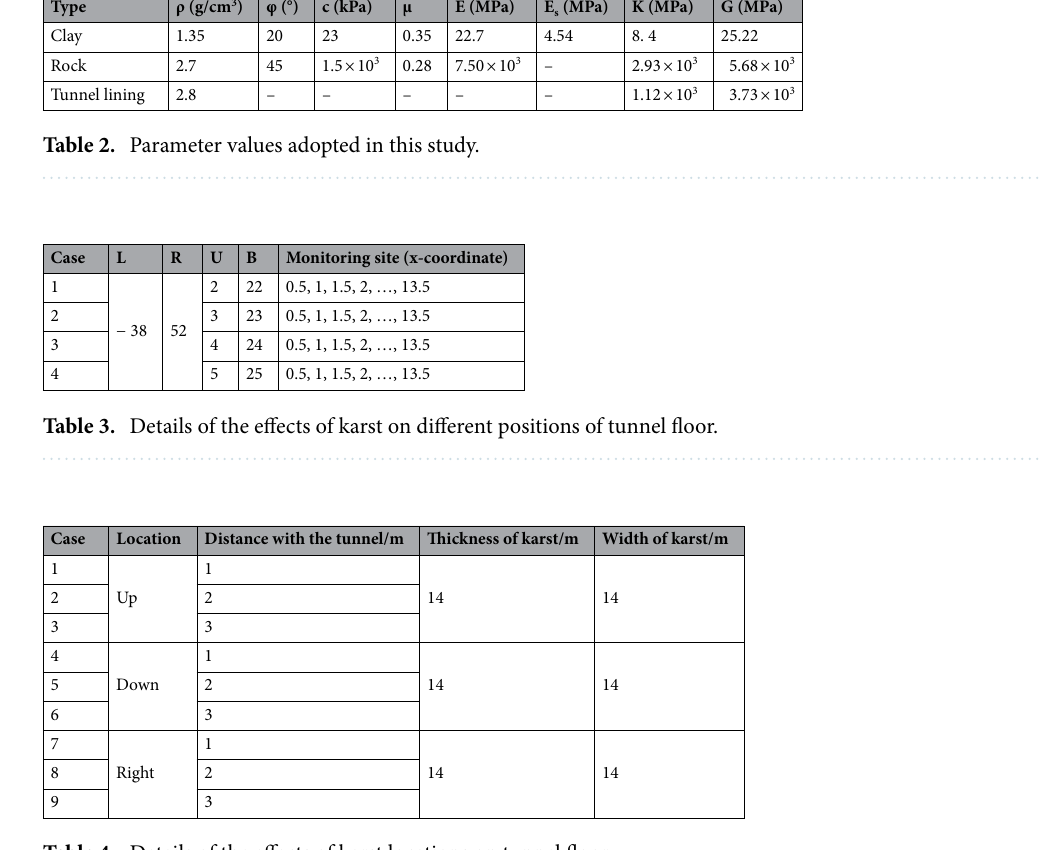
Table 4. Details of the effects of karst locations on tunnel